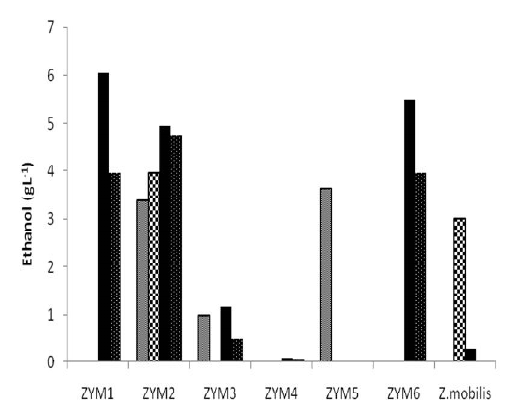
Fig 6. Effect of agitation on ethanol production by isolates. ( ) 50 rpm ( ) 100 rpm ( ) 150 rpm ( ) 200